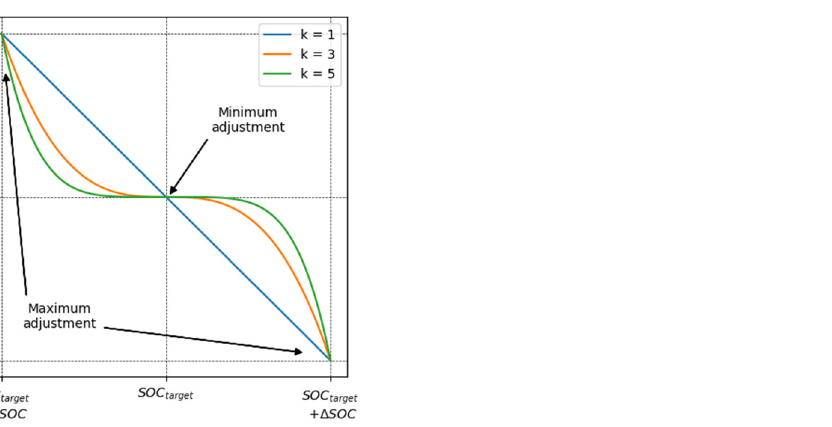
Figure 9. Cost of electric energy as a function of SoC. Based on [31] and authors’ further elabora- tion.